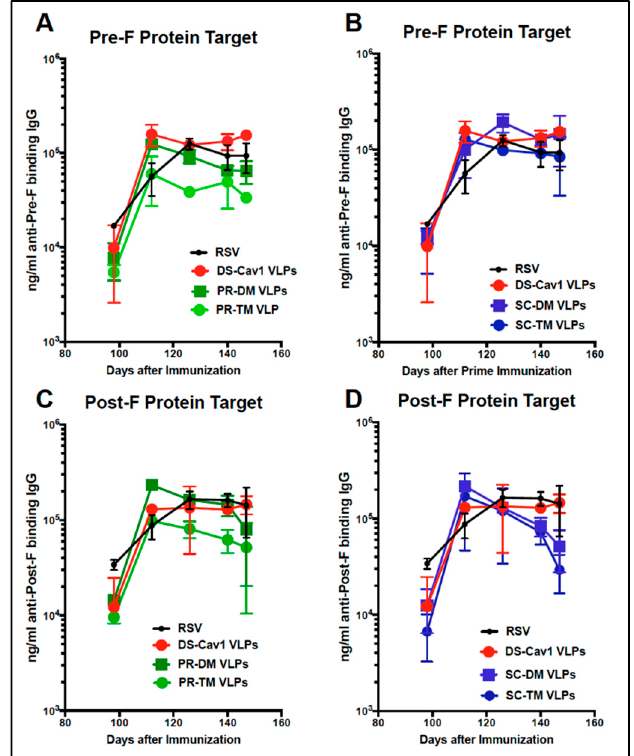
Figure 6. Total anti-pre-F and post-F binding IgG in sera after immunization with different VLPs. Total anti-pre-F binding (Panels A , B ) and post-F binding (Panels C , D ) IgG in pooled sera at each time point after the boost immunization was determined by ELISA using soluble DS-Cav1 protein (panels A and B ) or soluble post-F protein (panels C and D ) as the target antigen. Panels A and C compare titers in DS-Cav1 VLP sera with those in sera from PR-DM or PR-TM VLP sera. Panels B and D compare titers in DS-Cav1 VLP sera with those in sera from SC-DM or SC-TM VLP sera. Shown are the mean and standard deviations of three separate determinations. There were no statistically significant differences between titers at each time point (student t test).